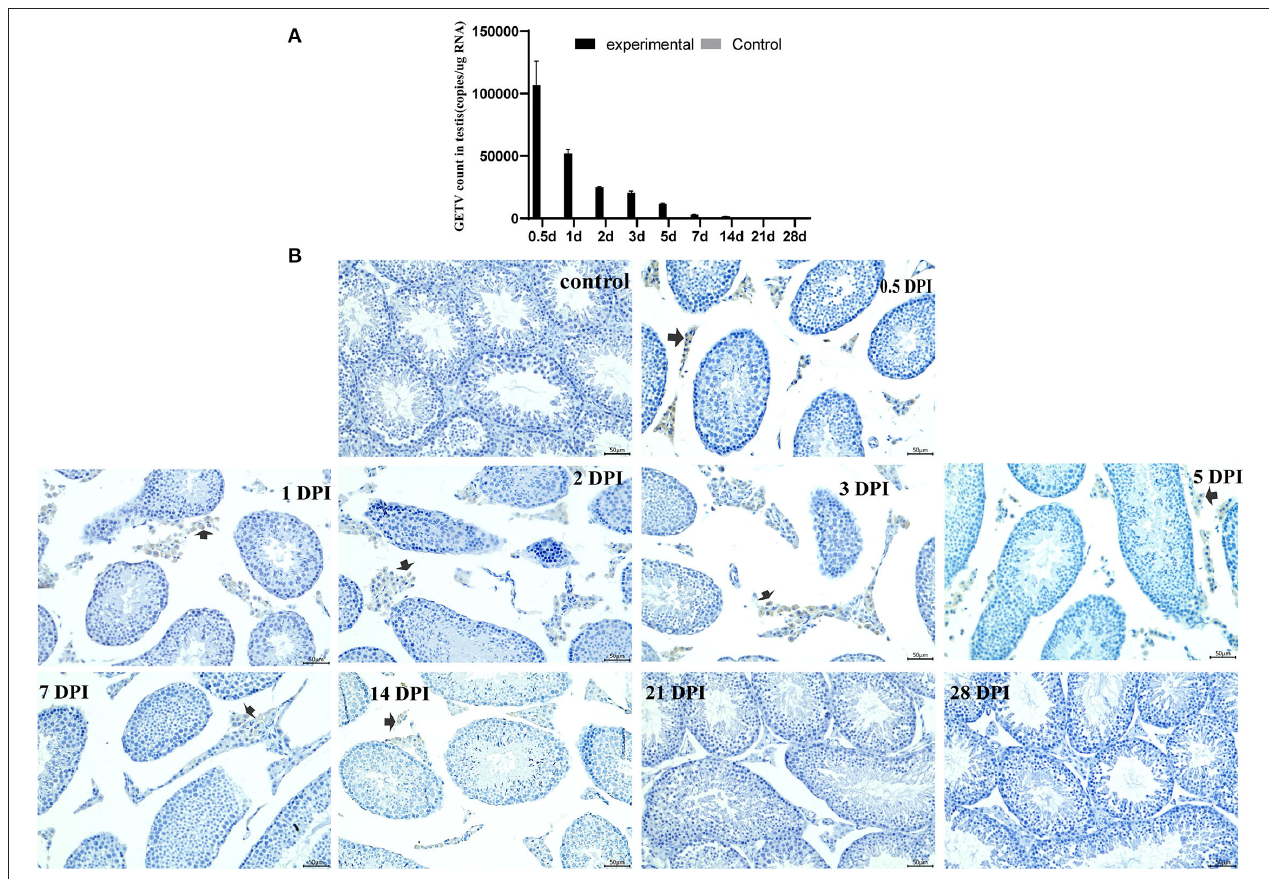
FIGURE 4 | Detection and persistence of Getah virus in the testis. (A) The GETV copies in the testis; (B) the testis immunohistochemical images. (control) Control testes from the control mice were given an injection with PBS at 7 dpi. The other is GETV-infected testes at 0.5–28 dpi. GETV E2 protein-positive cells are brown